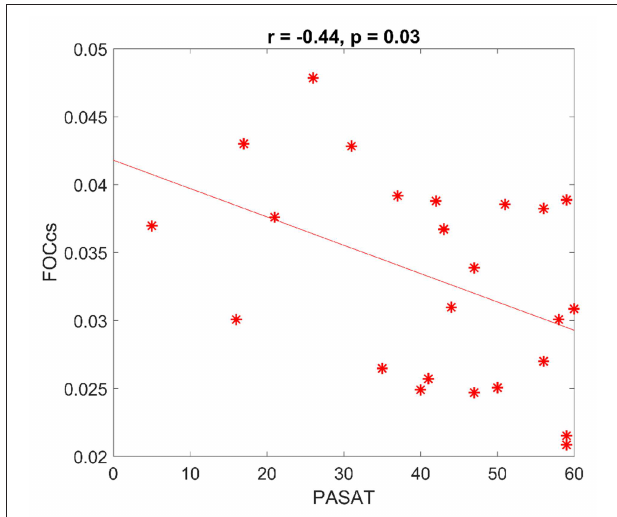
FIGURE 3 | Dynamic functional connectivity and cognition in multiple sclerosis (MS). FOCcs, which represent dynamic interhemispheric connectivity, are negatively correlated with Paced Auditory Serial Addition Test (PASAT) scores. FOCcs: flexibility of homologous connections. Each * represents each